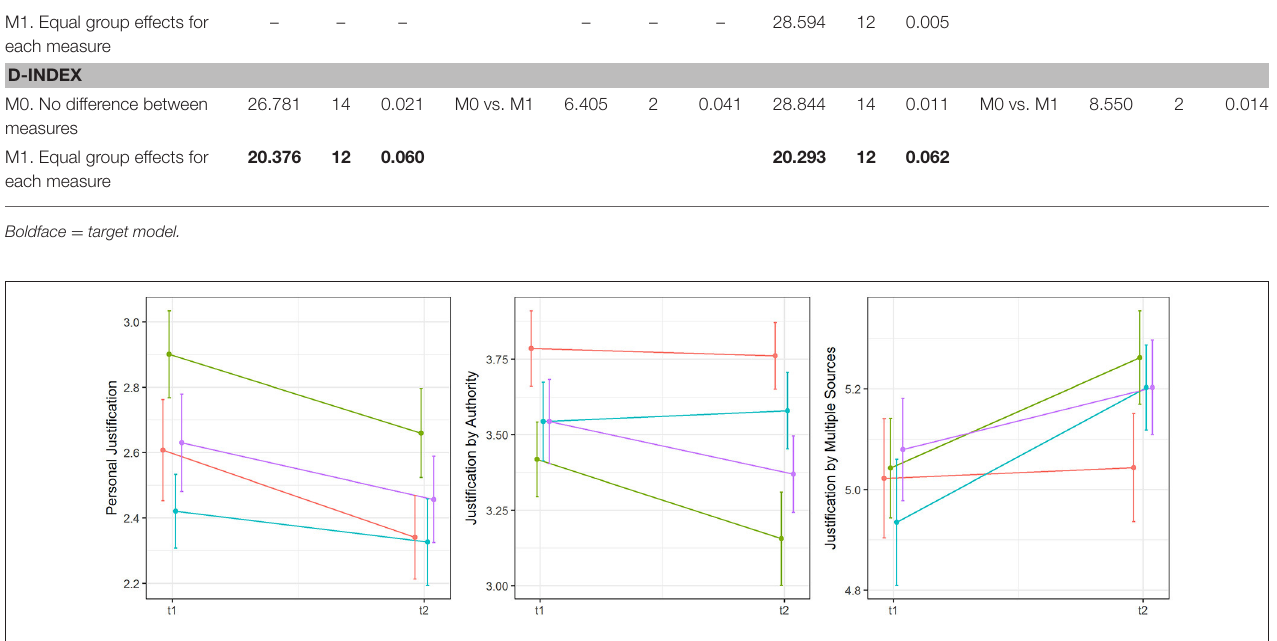
gender-stereotypes for justification by multiple sources ( 1 χ 2 = 4.010, df = 1, p < 0.05, see Table 8 for more details).